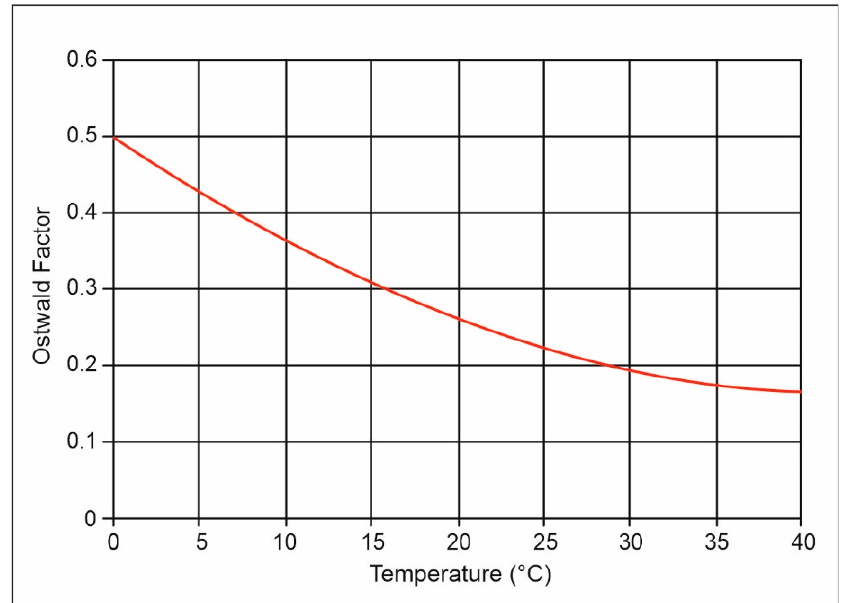
Figure 2. Ostwald’s Coefficient as a Function of Temperature [5] (Redrawn).